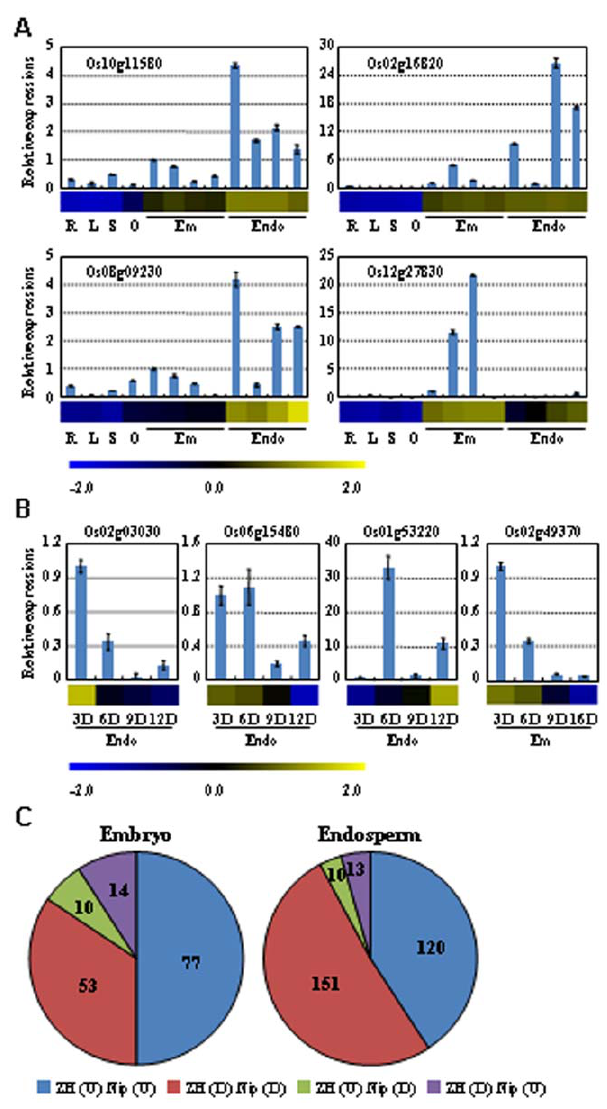
Figure 2. Corroboration of expression patterns of genes associated with seed development. The results by qRT-PCR analysis (box plot) are compared with data obtained from microarray hybridization (horizontal bars) to validate the predominantly expressed genes (A) and regulated genes (B). Expression of genes in root (R), leaf (L), seedling (S), ovary (O), embryo (Em) and endosperm (Endo) was analyzed and the value at 3 DAF in embryo was set as 1.0 for predominantly expressed genes (A). For the time course expression (B), the first time point was set as 1. Blue and yellow in cells reflect low or high expression levels, respectively, as indicated in the scale bar. The numbers of genes with different pattern in Zhonghua 11 (ZH) and Nipponbare (Nip) were calculated in embryo and endosperm (C). ‘‘U’’ or ‘‘D’’ in parenthesis indicates the genes are up-regulated or down- regulated. The data of Nip were obtained from Gene Expression Omnibus (GSE21494).